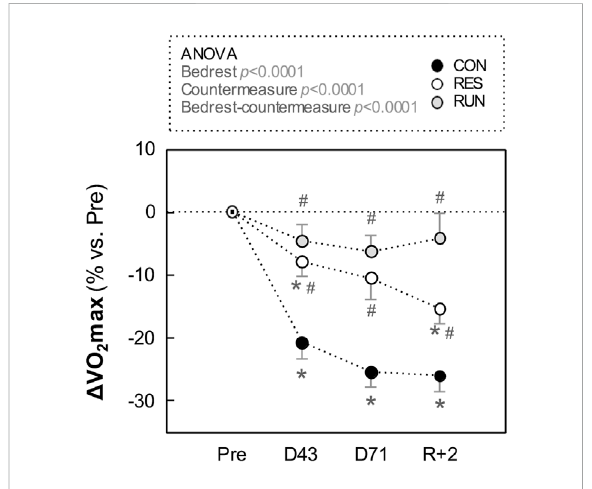
FIGURE 3 Evolution in maximal oxygen uptake (V _ O 2 max) during HDBR. Measurements were performed in the – 6 ° position using a bicycle ergometertestbefore (Pre),during(at day43andday71),andafter (R+2:2nddayofrecovery)HDBR.Thesamplesizewas n =8/ CON, n = 7/RES, n = 7/RUN. Data are presented as the mean